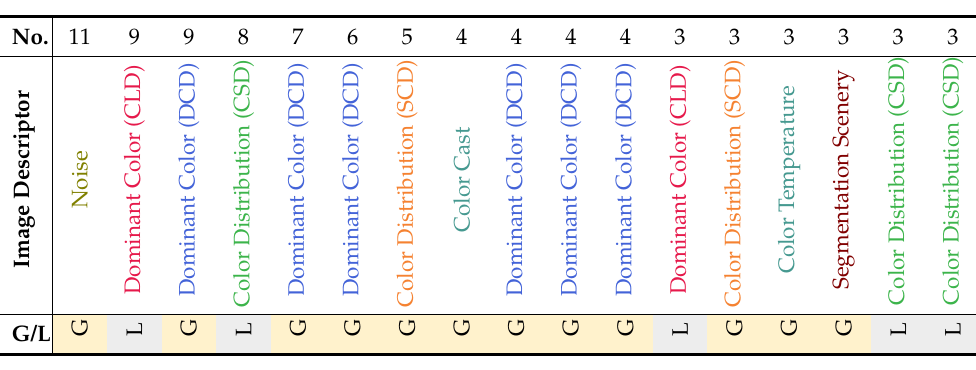
Table 1. Ranking of the most influential image descriptors in distinguishing real and synthetic image pairs. The first line is a count of the number of those FS/FI methods that judged the image descriptor mentioned in the second line as influential. The last row states whether it is a global or local image descriptor. Dataset: